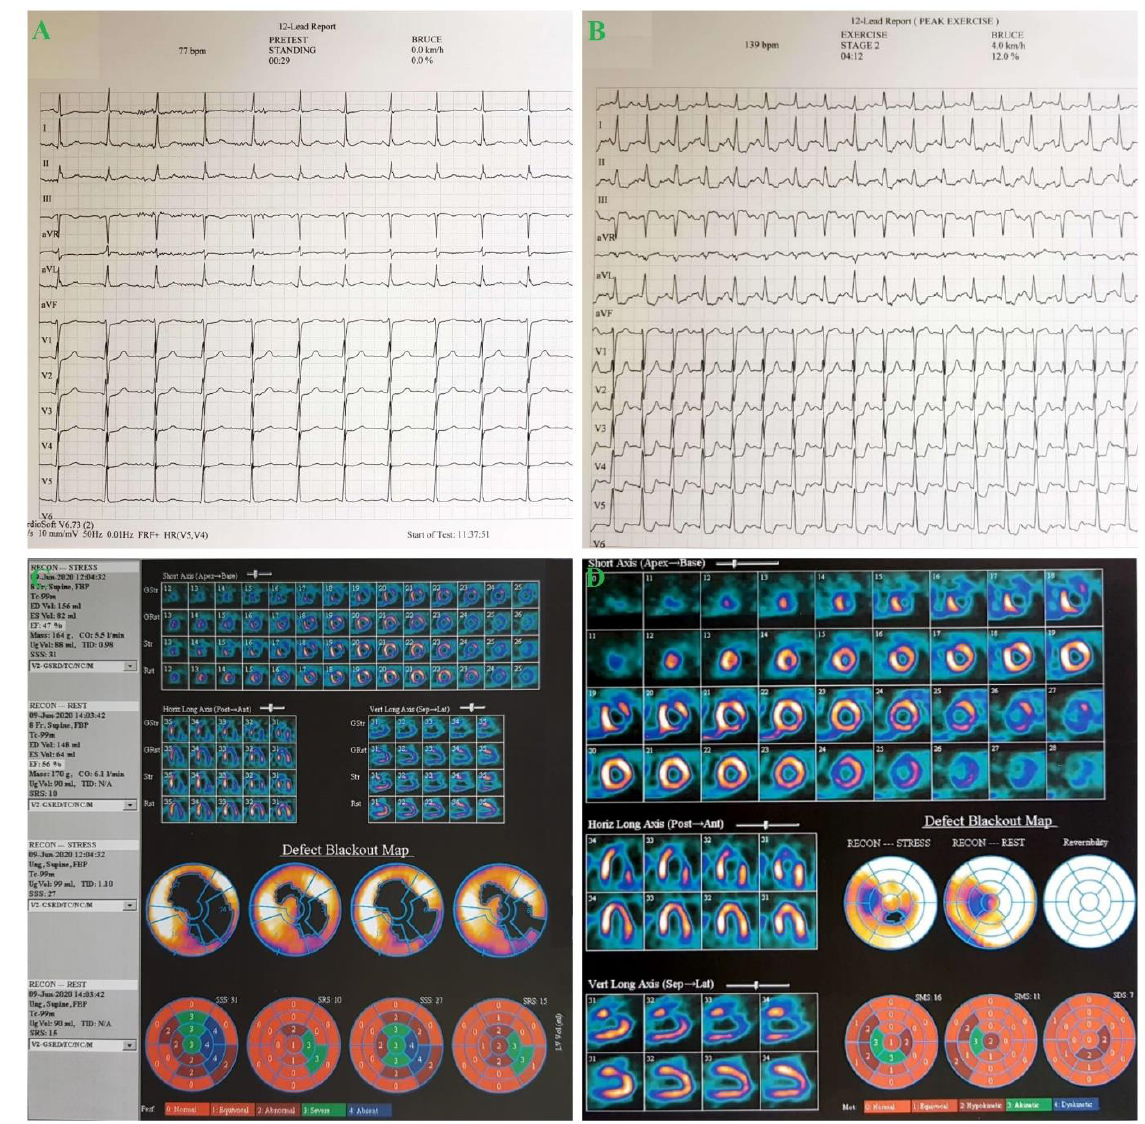
Figure 3. ( A , B ): Bruce protocol stress test—after 2 and a half minutes the patient complained of chest pain (8/10 intensity), and at the 4th minute (stage 2) the test was stopped because of the pain and electrocardiogram (ECG) findings: at 140 bpm, widespread horizontal ST depression, most prominent in DII, DIII, aVF and V4-V6 and ST elevation in aVR > 1 mm; ( C , D ): Myocardial perfusion scintigraphy stress induced mild left ventricular global hypokinesia and left ventricular systolic dysfunction (LVEF 45–47%).